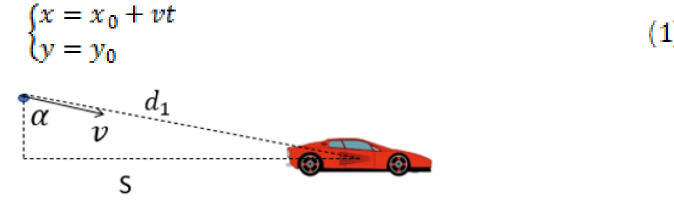
Fig. 2. The trajectory of the vehicle is not approximately a straight line.